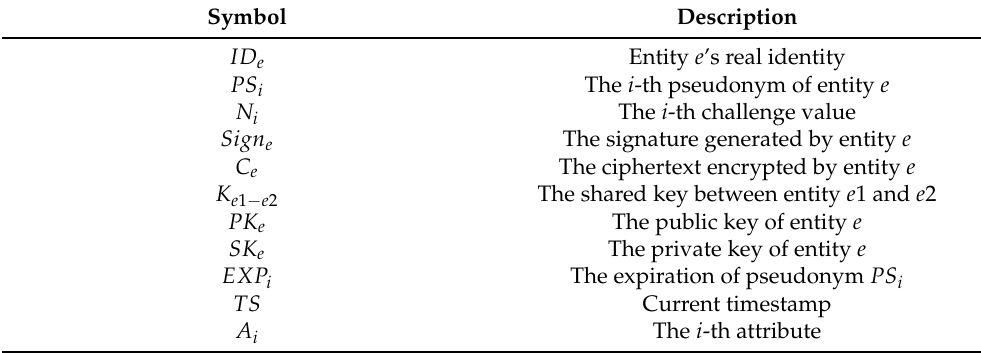
Table 1. Symbol and description.